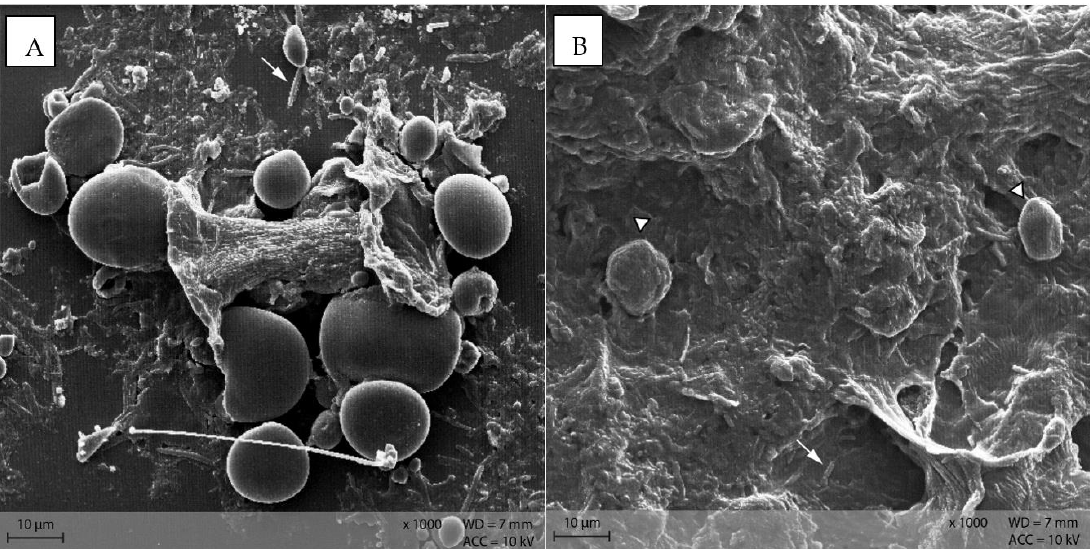
Figure 10. Starch particles in the stomach content of group ( A ) PEL, and ( B ) EXT; note the rod-shaped bacteria in the surroundings of the starch particles. (Scanning electron microscopy; ↓ indicating bacteria, ∆ marking irregularly shaped starch particles in B).